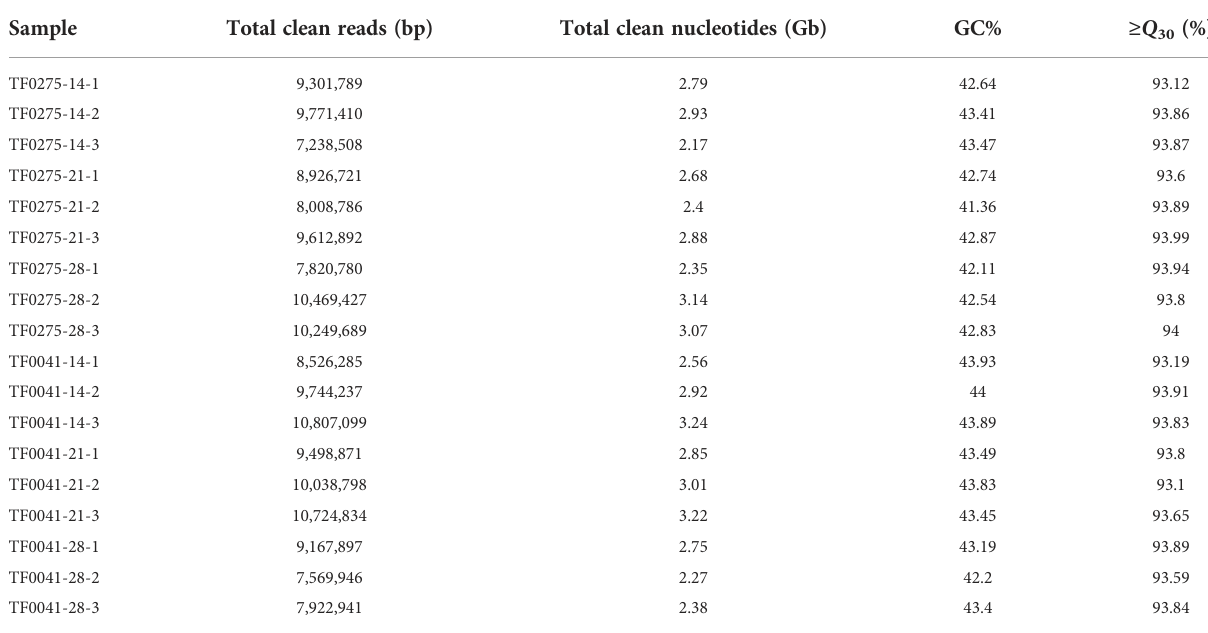
TABLE 4 Summary of the sequence data